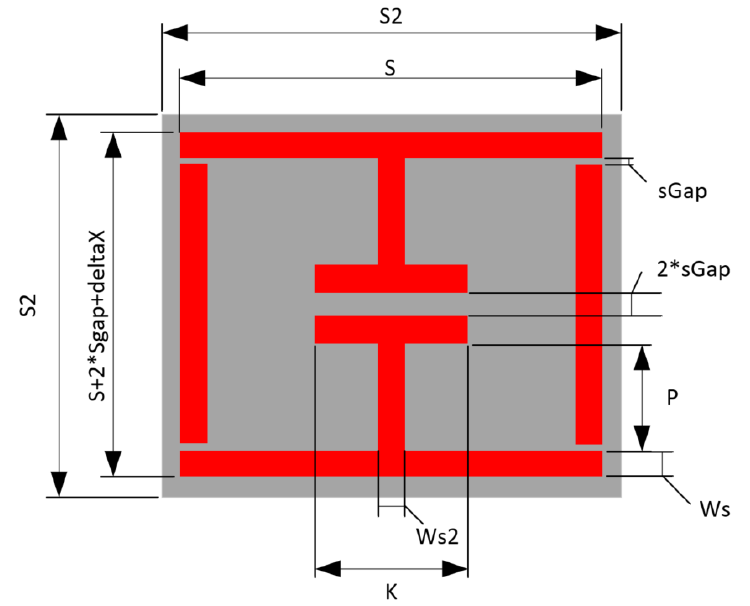
Table 3. Latex EDM tag dimensions.